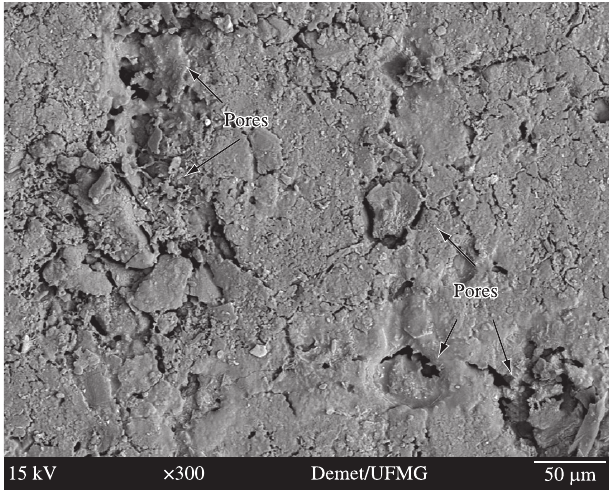
Figure 8. Composite C11, backscatter-mode scanning electron microscopy